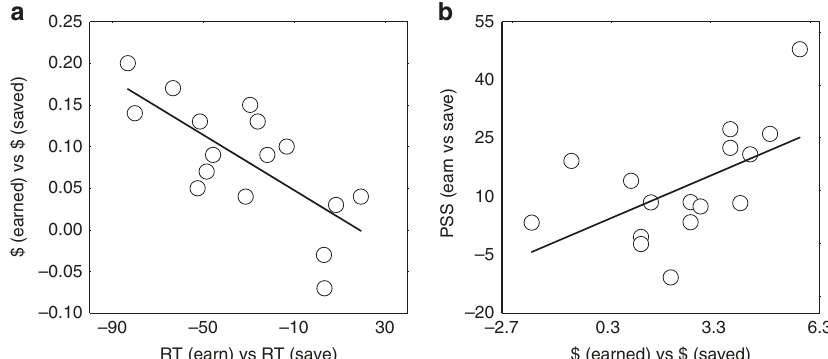
Fig. 3 Differential behavioral and attentional salience for earning and saving. a Individual differences in behavioral responses (response time, RT) for earn versus save during reinforcement were related to the amount of money earned versus saved; b individual differences in reinforcement monetary advantage for earnings over savings were related to the magnitude of the earn-save asymmetry in temporal-order judgment, i.e., PSS (earn versus save)